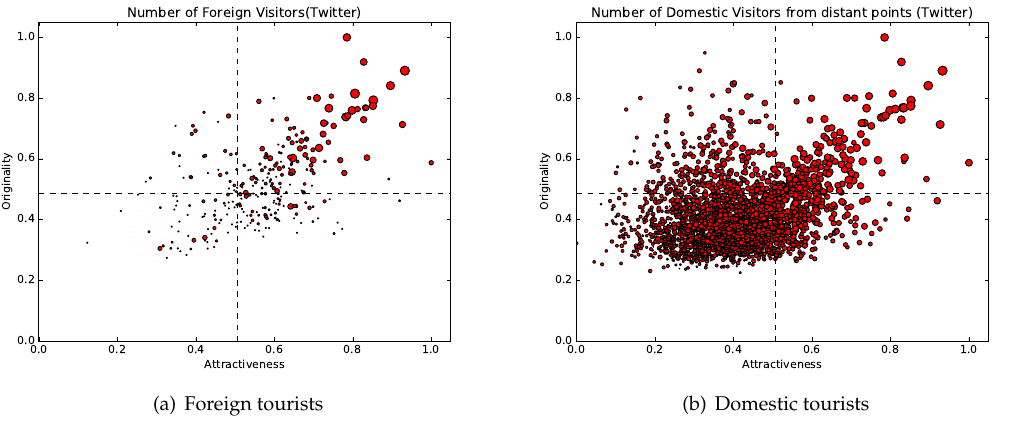
Figure 7. Number of tourists and its relationships with attractiveness and originality: The radius of each circle is proportional to the logarithm of the number of